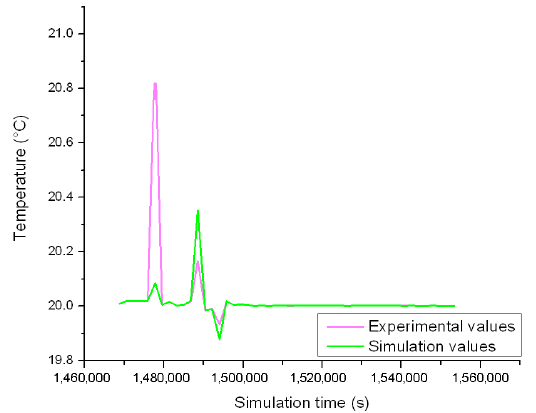
Figure 18. Experimental vs. simulation temperature curves for the 18th of November.